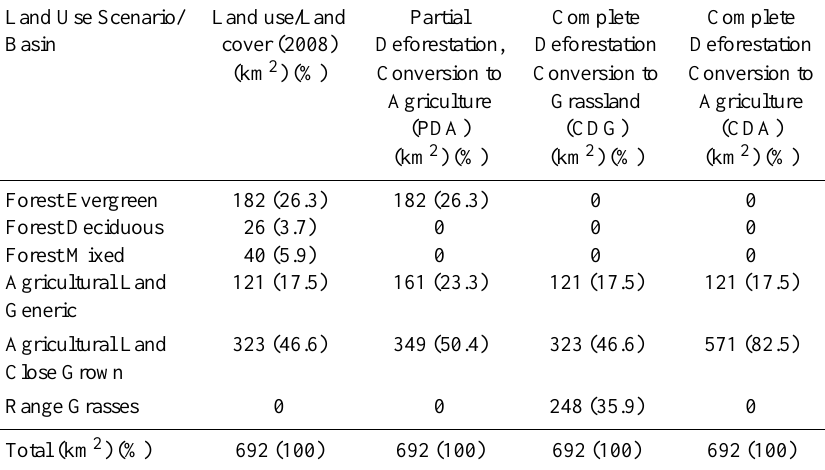
Table 9. Areal coverage of land use and percentages in the Nyangores sub-basin for the 2008 cover as well as cover under three scenarios of future land use change.